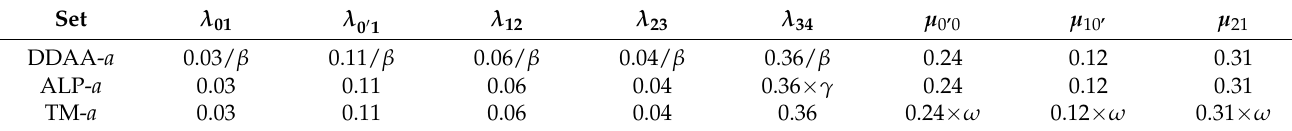
Table 7. State transition rate (per hour) adjustments under the DDAA, ALP, and